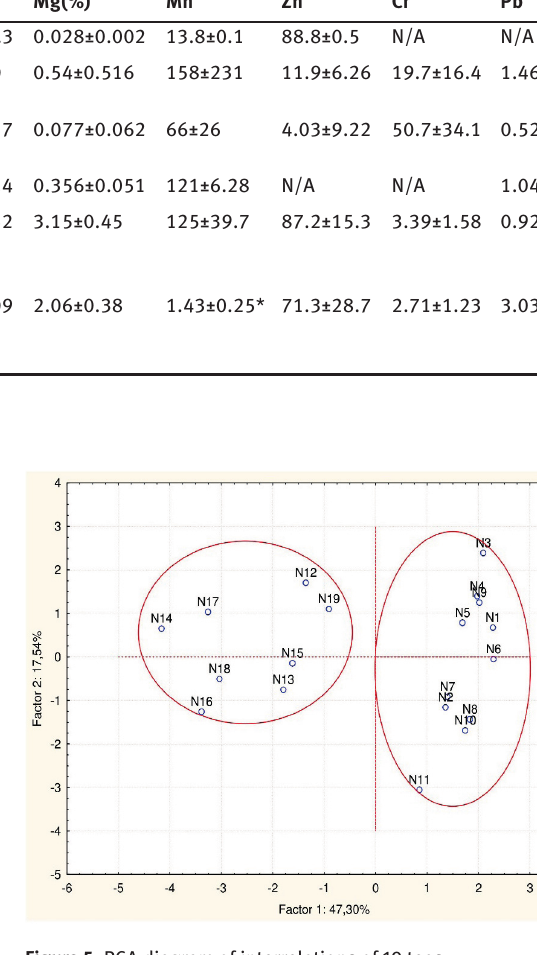
Figure 5: PCA diagram of interrelations of 19 teas.